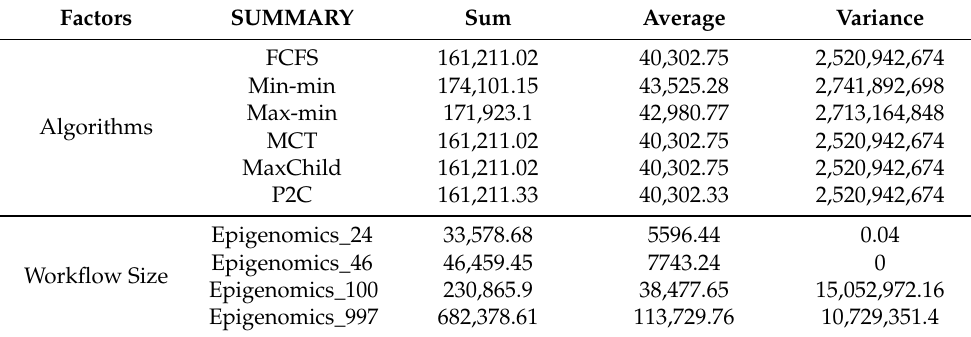
Table 10. Two way ANOVA Summary results for Epigenomics Workflow.